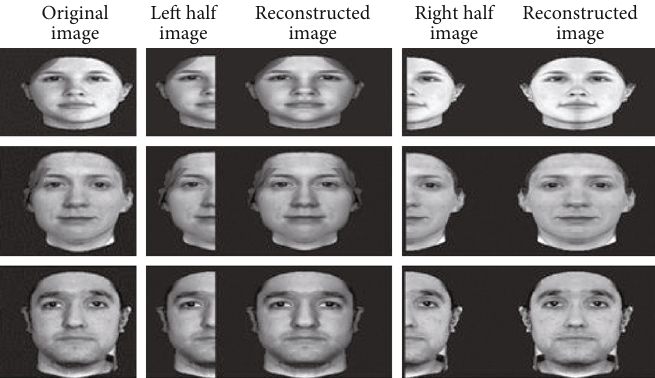
Figure 3: Reconstructed images from left and right segmented half images. Source: Asiedu et al.